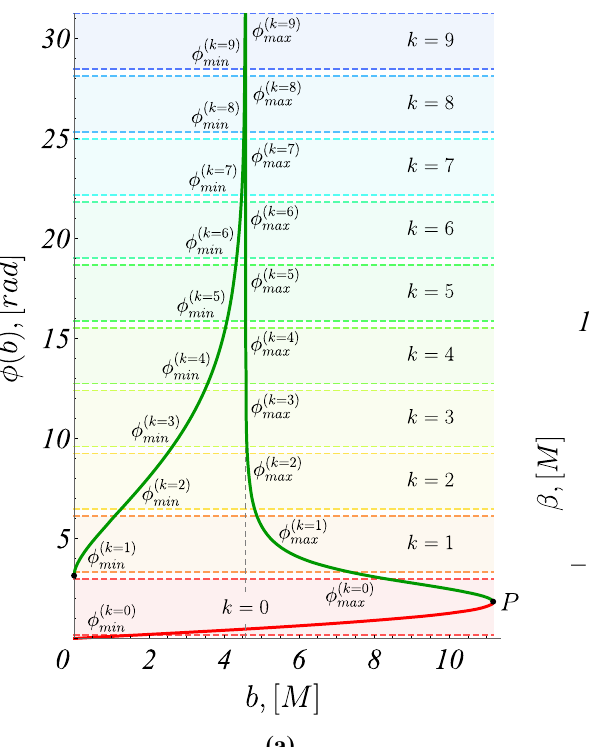
Fig. 4 Imageformationdiagramforacircularorbitfromtheouterdisk ( a ), and the corresponding observable image ( b ). The orbit is located at the radial coordinate r = 10 M , while the observer’s position is at